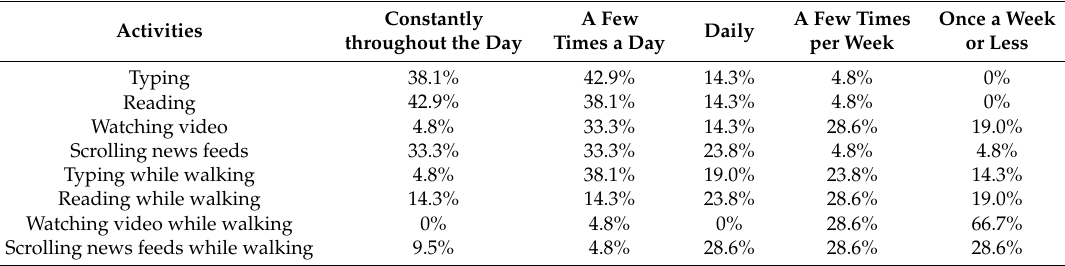
Table 8. Frequencies of participants’ smartphone